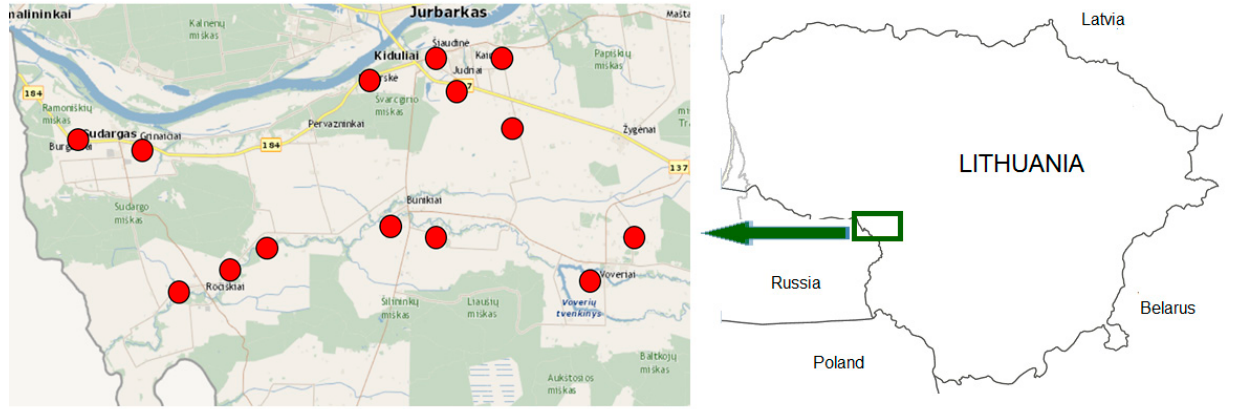
Figure 2. Map of the study area. Locations where data were collected are marked with a red circle.